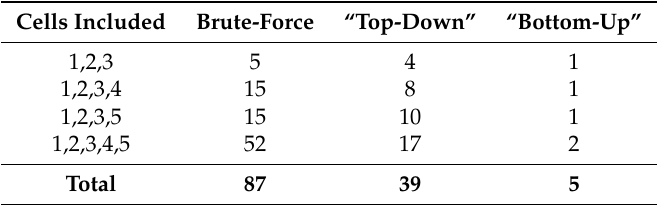
Table 1. Dynamic Programing (DP) formulation comparison (number of solutions calculated). Cells Included